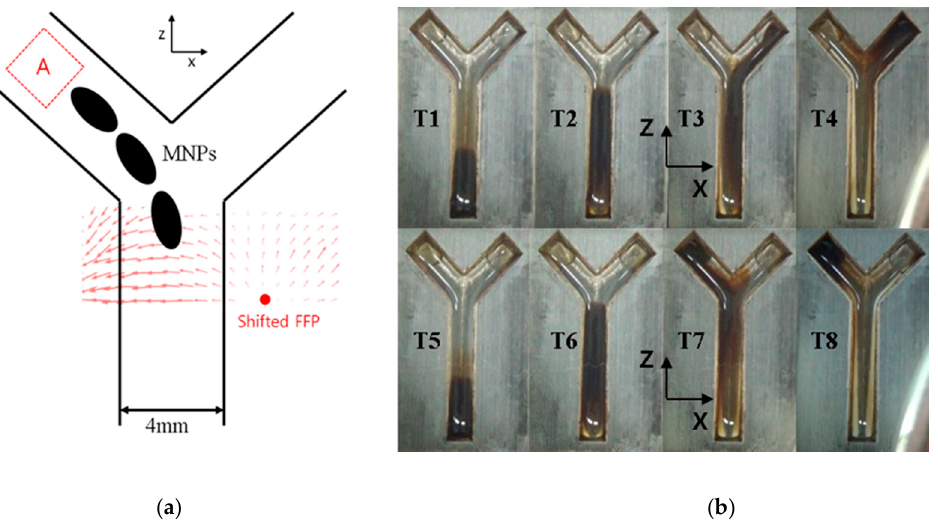
Figure 10. Nanoparticle manipulation to drive them to the targeted point: ( a ) schematic of steering the particles and ( b ) experimental